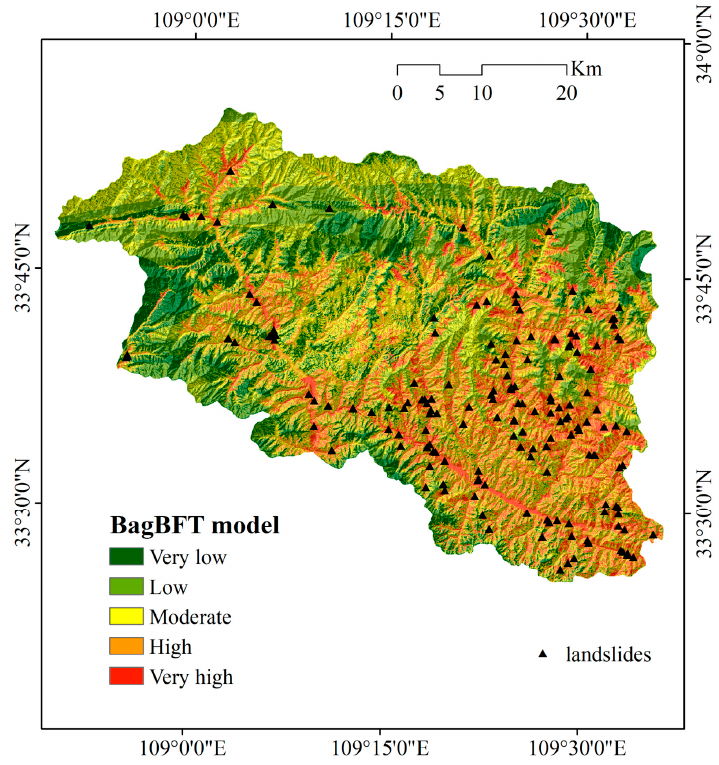
Figure 5. Landslide susceptibility map using the BagBFT model.